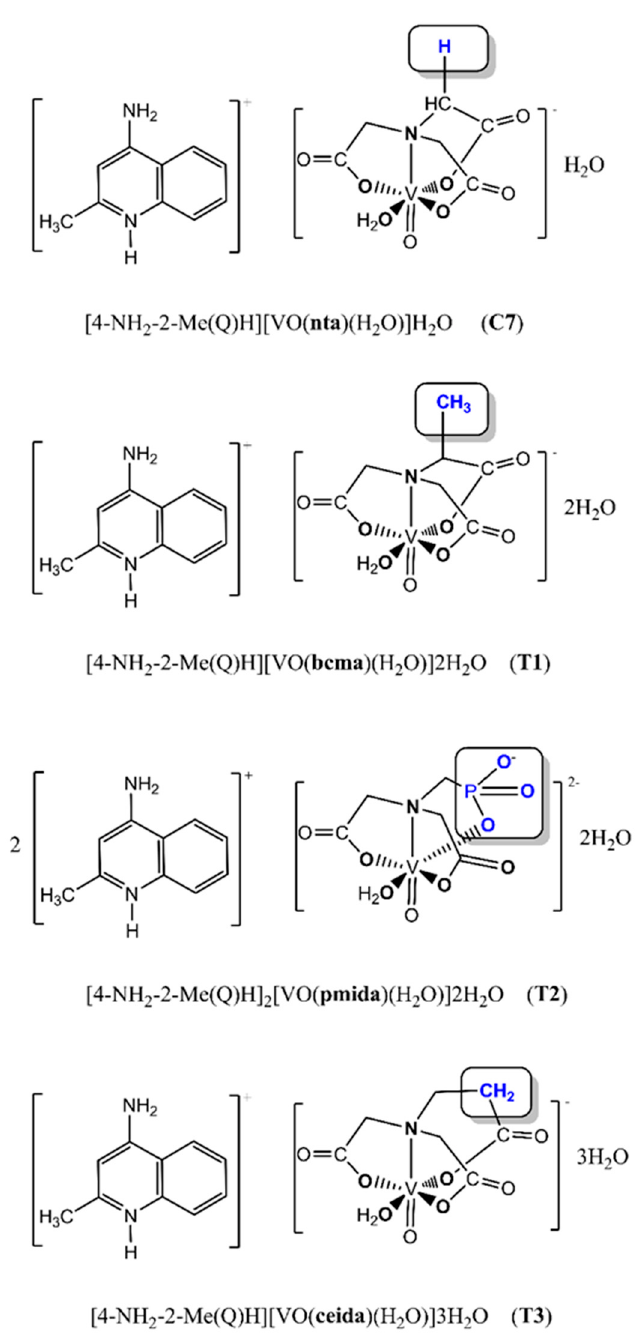
Figure 1. The chemical structures of T1–T3 complexes (derivatives of C7).